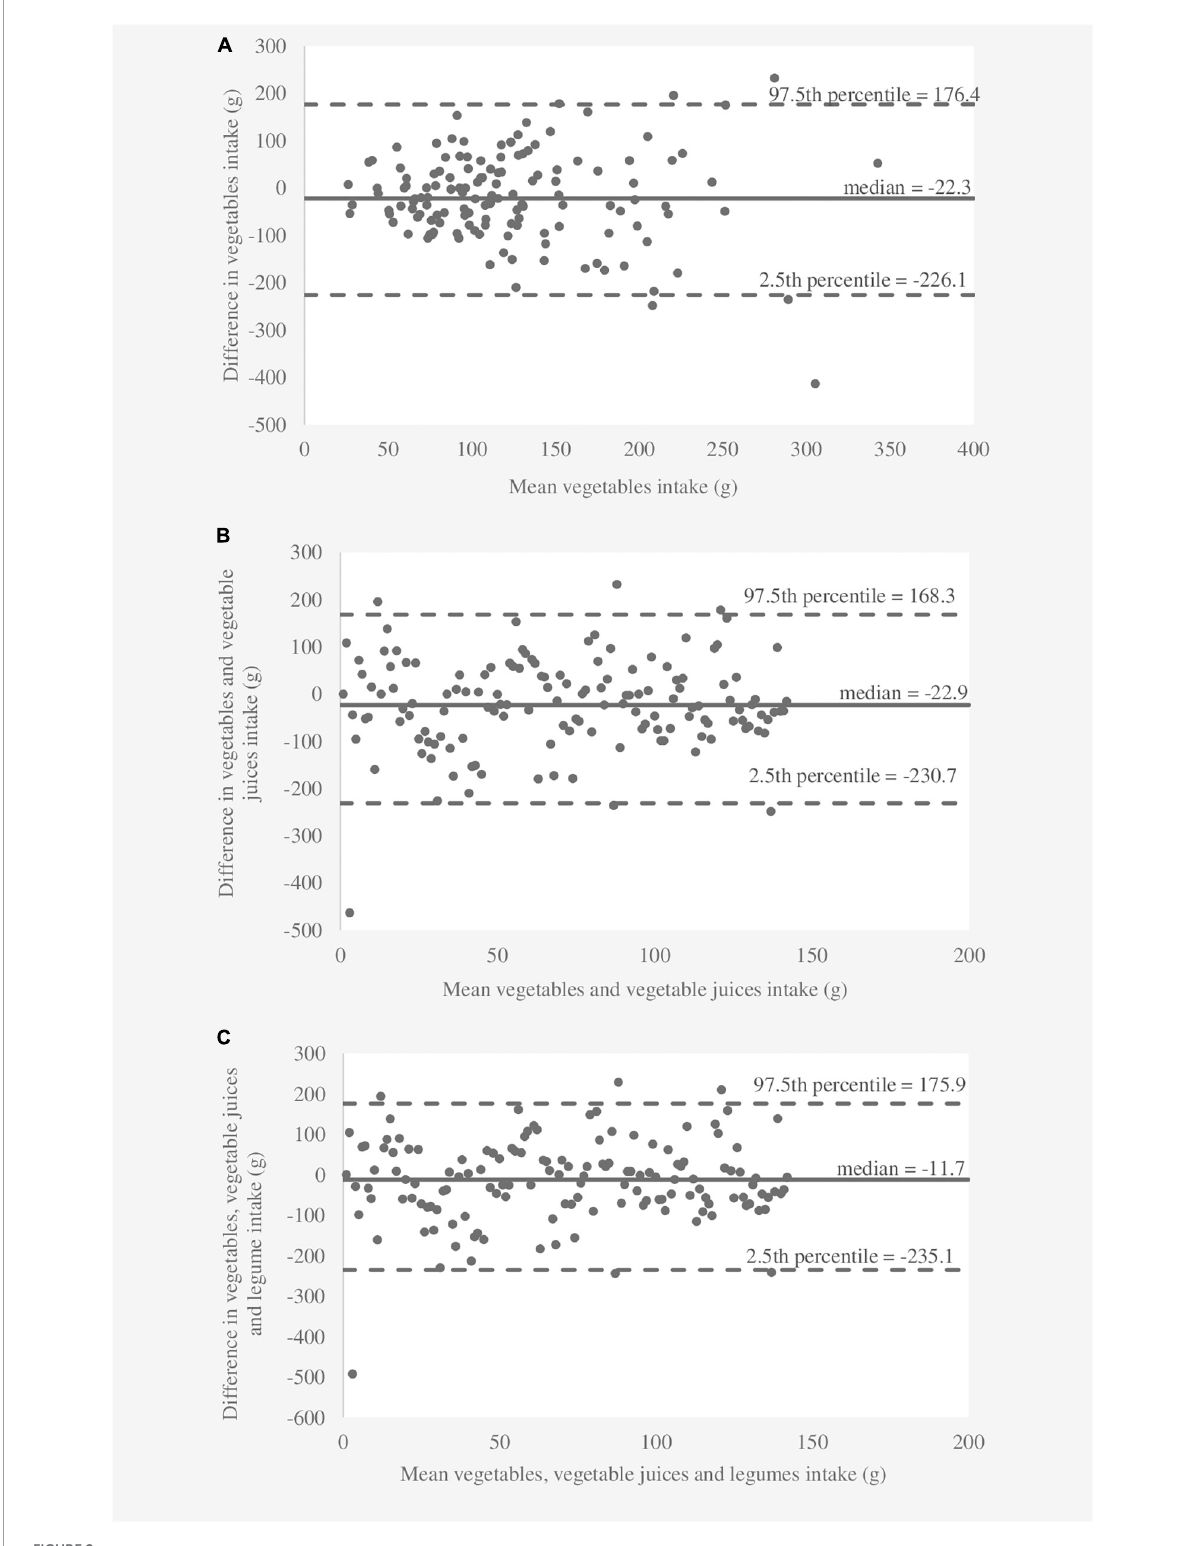
FIGURE2 Bland–Altman plots showing agreement between the 3-day dietary records and the first food frequency questionnaire for consumption of (A) “vegetables,” (B) “vegetables and vegetable juices,” and (C) “vegetables, vegetable juices, and legumes” per day.